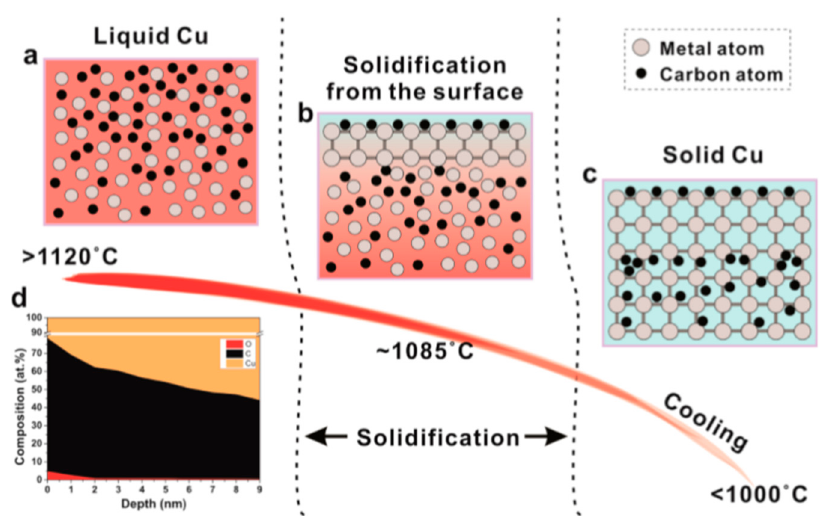
Figure 20. Schematic illustration of the carbon distribution in ( a ) liquid Cu, ( b ) solidified surface of the liquid Cu and ( c ) solid Cu. ( d ) XPS composition profile showing elements (O, C and Cu) along the surface after CVD graphene growth showing a larger amount of C dissolved in bulk, demonstrating the increase in carbon solubility in Cu at its liquid state (reprinted with permission from